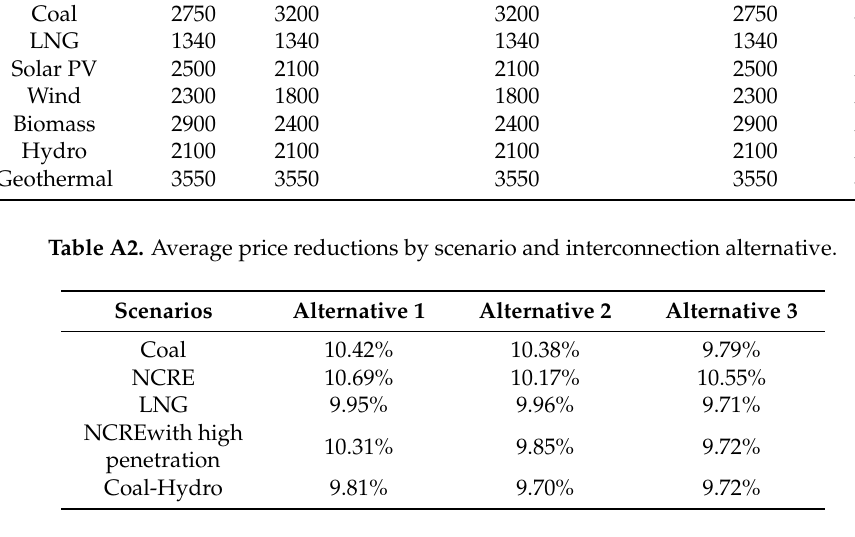
Table A3. Average net benefits (investment and operation) of interconnection by scenario.